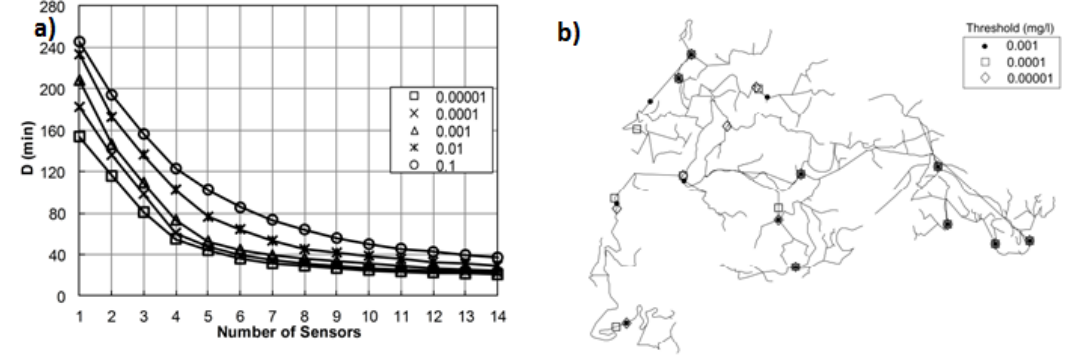
Figure 4. Procedure GR1 for different detection thresholds: ( a ) D values as a function of the number of sensors; ( b ) sensor placement.